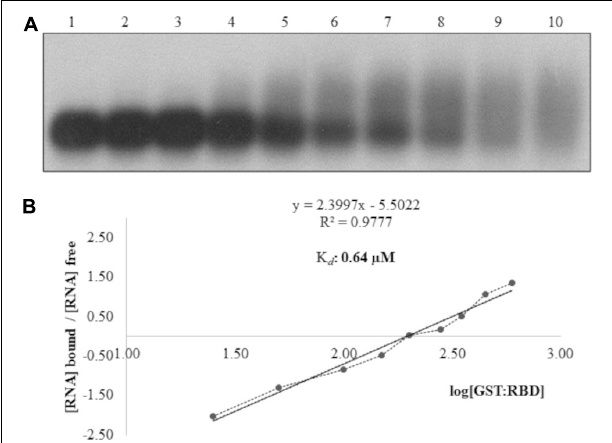
FIGURE 3 | Analysis of RNA–protein complexes formed between purified GST:RBD of at ALKBH9B protein and the 3’UTR transcript of AMV-RNA3/4. (A) EMSA after incubation of 5 ng of 3’UTR transcript with no protein (lane 1) or with 25, 50, 100, 150, 200, 280, 350, 450 and 600 ng of GST:RBD of 9B (lanes 2–10) corresponding to 0.08, 0.16, 0.33, 0.49, 0.65, 0.91, 1.14, 1.47, and 1.96 µ M, respectively. (B) Hill transformation. The thin line is the best fit determined by least-squares analysis, with the corresponding r coefficient and equation given in the insert. The slope of the best-fit equation determines a Hill coefficient of 2.4, and the y intercepted point gives the value of the apparent constant dissociation (K d ), which was 0.64 µ M.